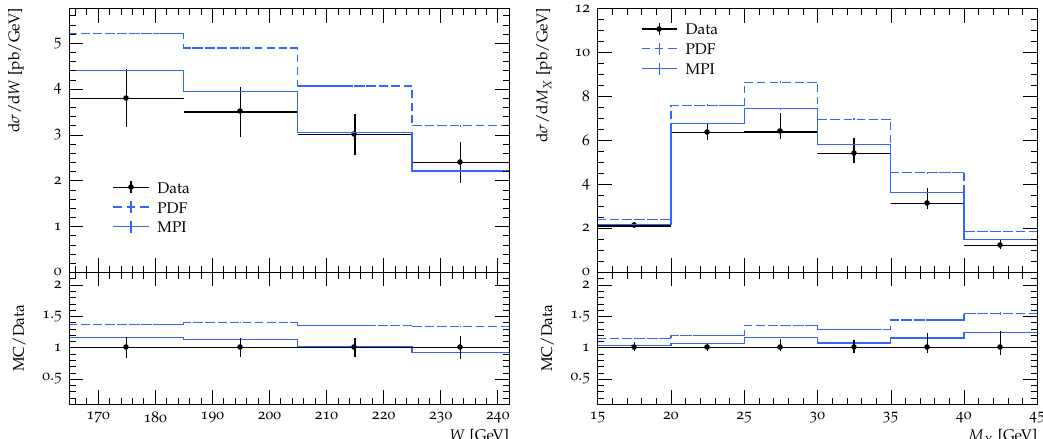
Figure 1: Differential cross sections in terms of invariant mass with (solid) and without (dashed) the MPI rejection compared to H1 (left) and ZEUS (right) measurements.